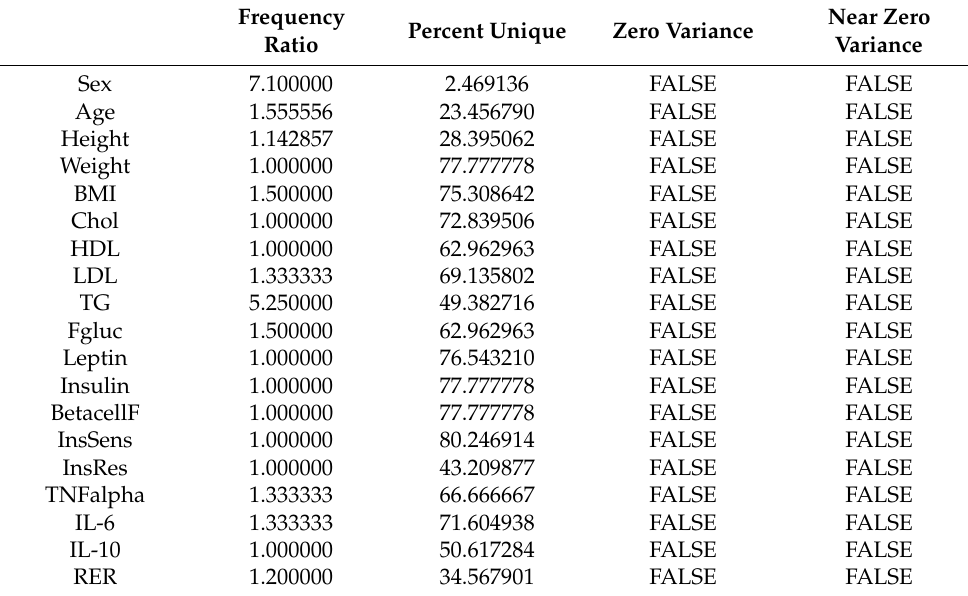
Table 2. Zero- and near zero-variance predictors